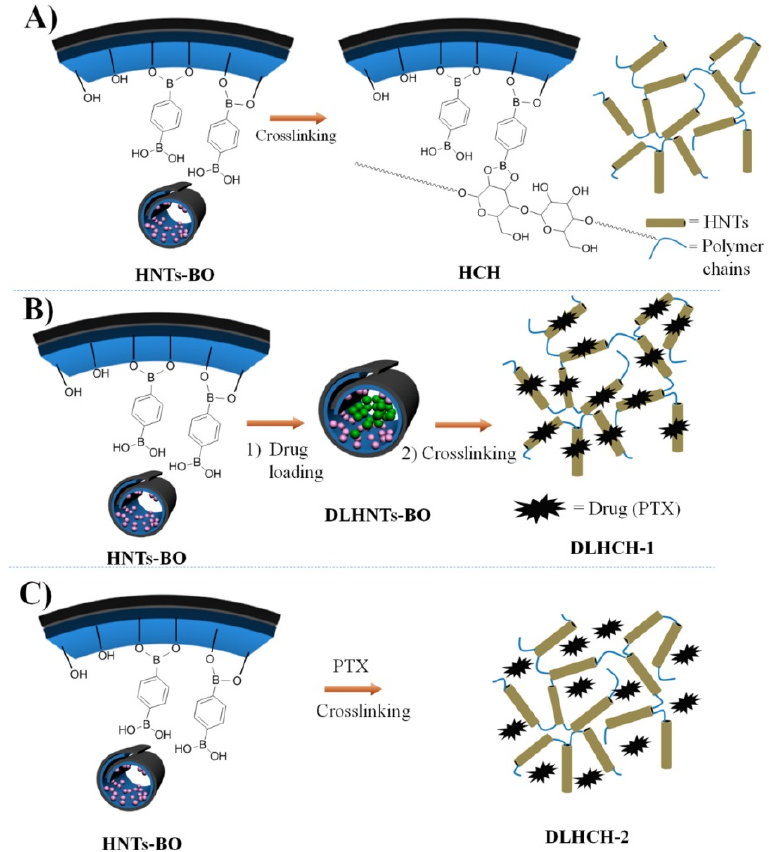
Figure 25. Preparation of HNT-based hydrogels. ( A ) The route and mechanism of preparing HCH; ( B ) preparation of DLHNTs-BO and DLHCH-1 (PTX was loaded in the lumen in DLHNTs-BO and DLHCH-1); ( C ) preparation of DLHCH-2 (PTX was embedded in the matrix network in DLHCH-2). Reproduced with permission from [173].